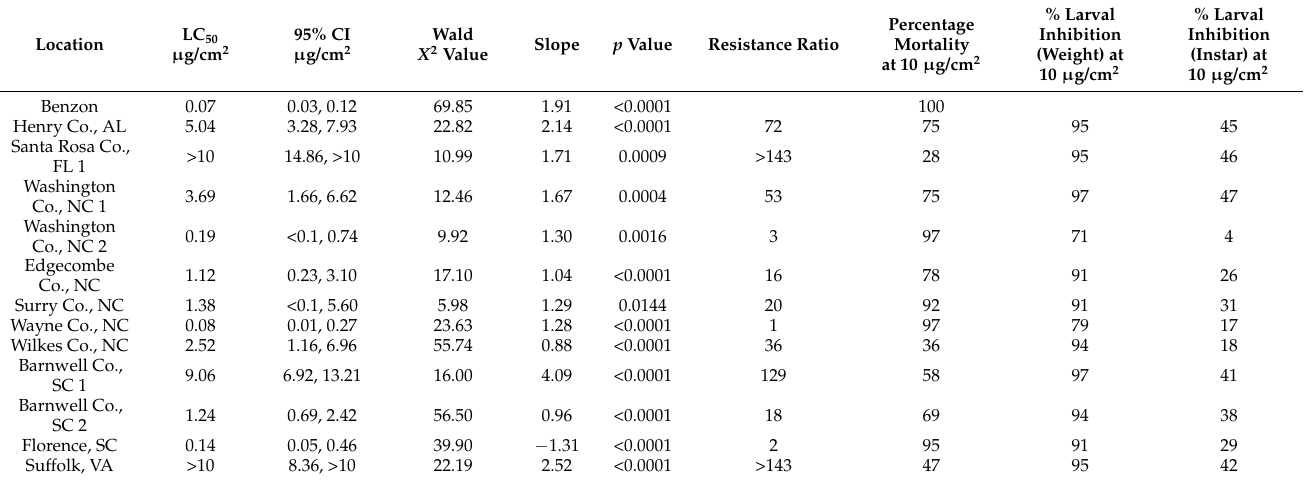
Table 3. Bioassay results for Cry2Ab2, 2019. 1 and 2 refer to different collections from the same county, but different locations within the